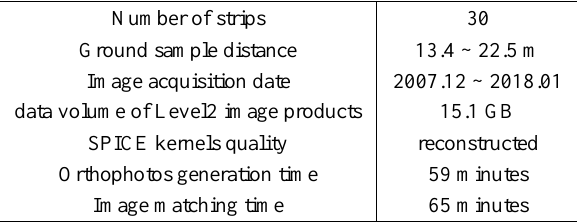
Table 1. Basic information of the test